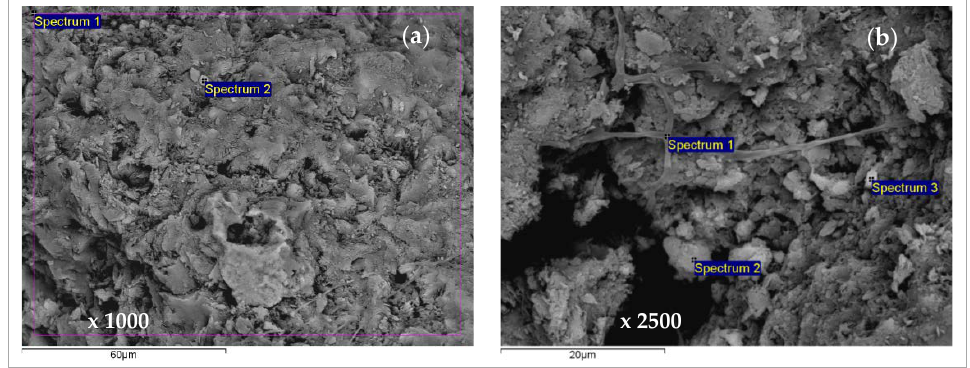
Figure 17. SEM images of zeolite grains for the (Cd + Zn) system and Cd/Zn = 1.07 with : ( a ) two spectrums with mean wt.(%) of 4.62 Cd and 2.22 Zn ; ( b ) three spectrums with mean wt.(%) of 3.52 Cd and 2.63 Zn.